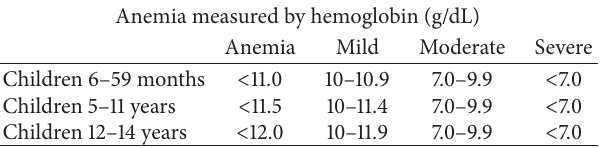
Table 1: Hemoglobin concentrations (g/dL) for the diagnosis of anemia and assessment of severity according to the WHO/UNICEF/ UNU